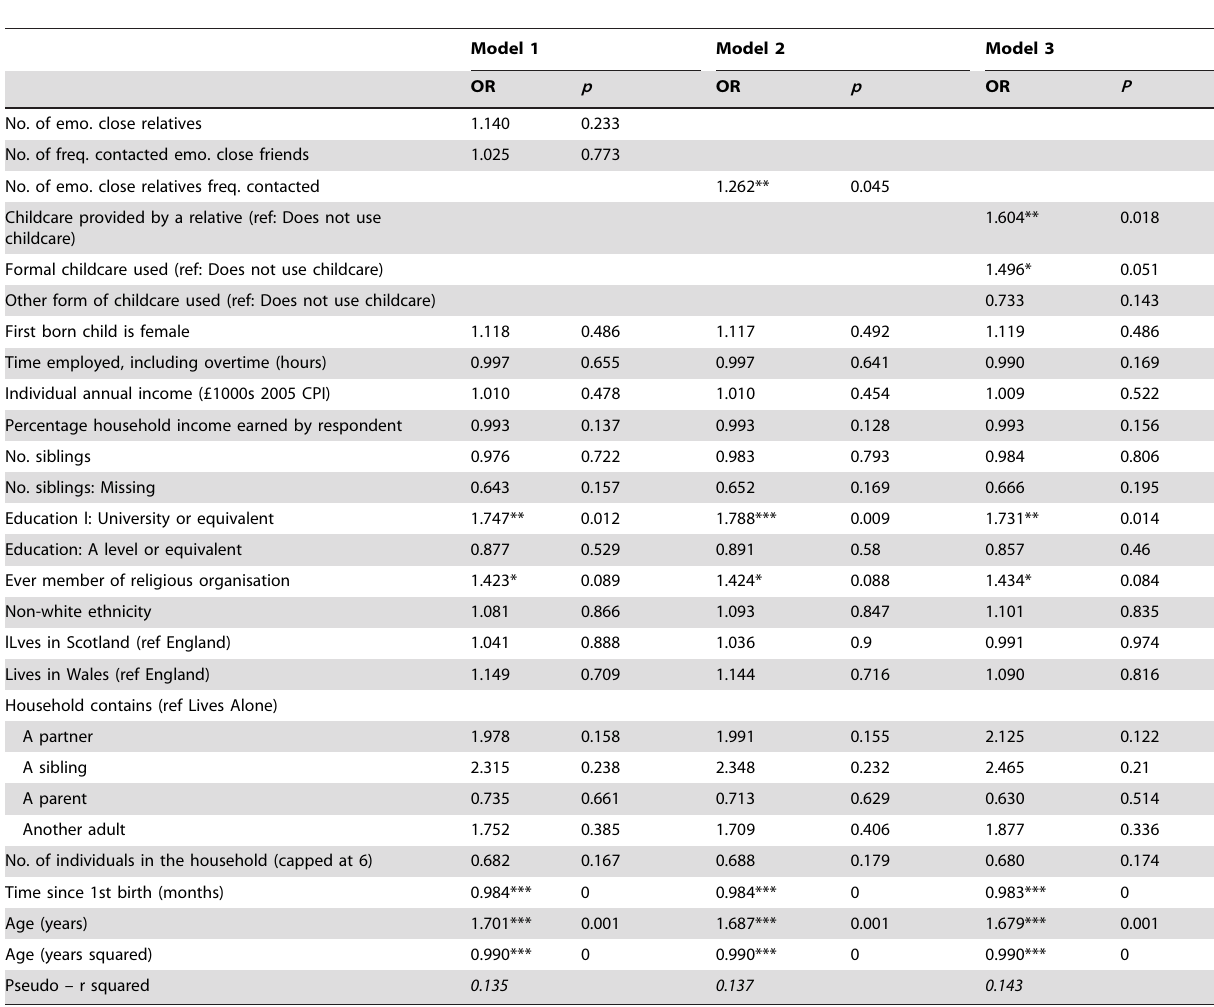
Table 4. Multivariate results - explanatory variables main